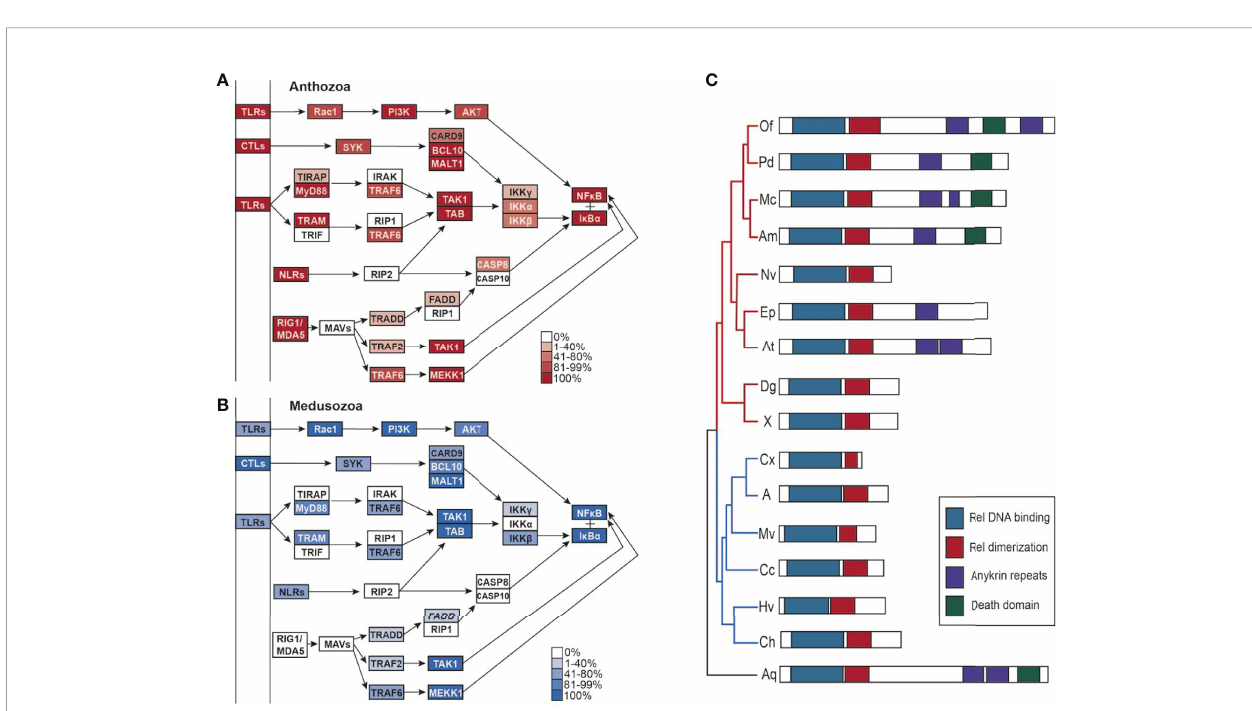
FIGURE 5 | (A, B) PRR-NF k B pathways modi fi ed from Kegg pathway. Opacity of the boxes represents the percentage of (A) Anthozoans or (B) Medusozoans with that pathway component. (C) schematic of the domains found in NF k B in each species, grouped by phylogeny. Medusozoan species are indicated by the blue phylogenetic tree branches. Anthozoan species indicated by the red phylogenetic tree